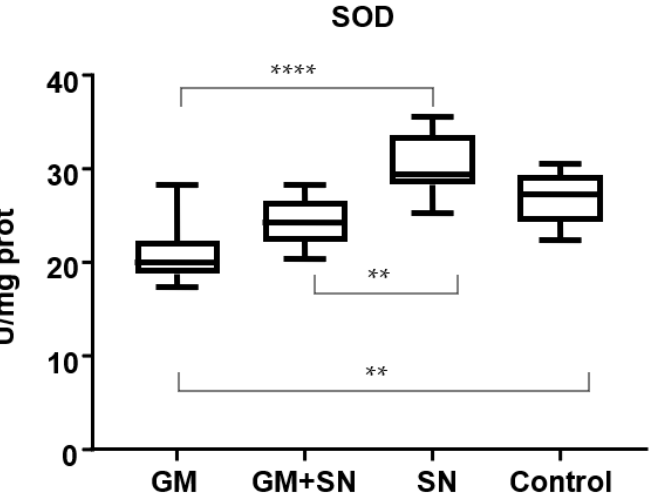
Figure 4. Superoxide dismutase (SOD) level in the investigated groups (** p < 0.01, **** p < 0.0001). GM—gentamicin group, GM+SN—gentamicin and Sambucus nigra group, SN— Sambucus nigra group, Control—control group (no treatment).